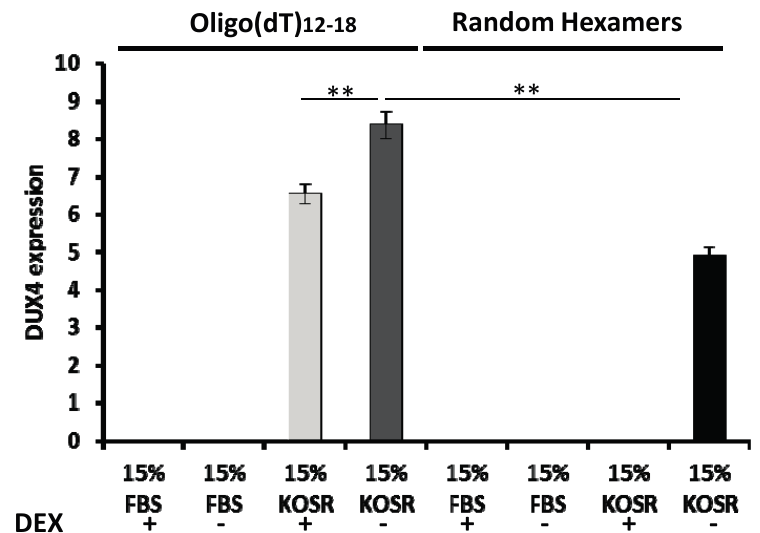
Figure 2. Higher sensitivity of DUX4 detection in cDNA samples synthesized using oligo(dT) primers compared to those synthesized using random hexamers. In addition, higher expression of DUX4 was detected in cells cultured in growth medium with 15% KOSR instead of 15% FBS. Adding dexamethasone reduced DUX4 expression. DEX, dexamethasone; FBS, fetal bovine serum; KOSR, knockout serum replacement; “**”: p < 0.01.